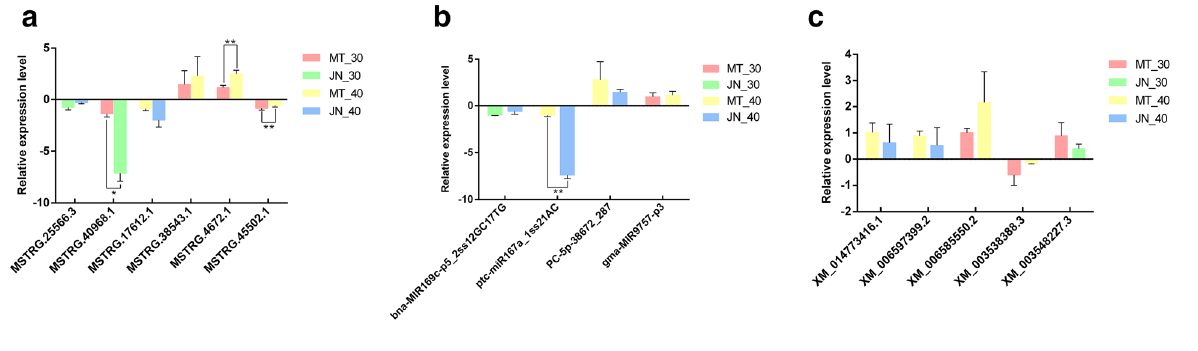
Figure 11. Validation of the expression pattern of four highly expressed lncRNAs by real-time PCR. *represents p < 0.05, there is statistical difference, **represents p < 0.01 with statistically significant